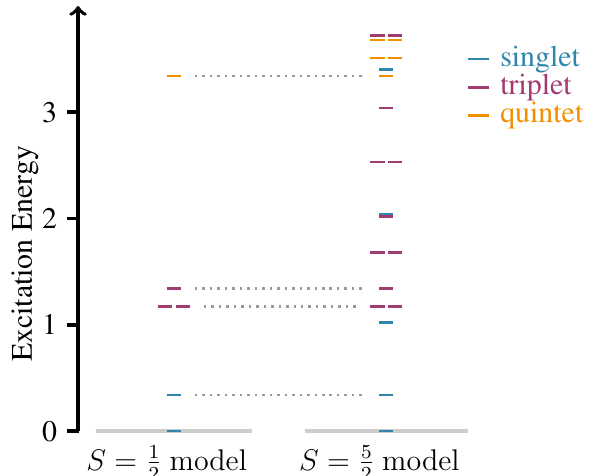
FIG. 6. The spectra of the S = 1 / 2 and S = 5 / 2 Heisenberg models for the [4Fe-4S] cluster.